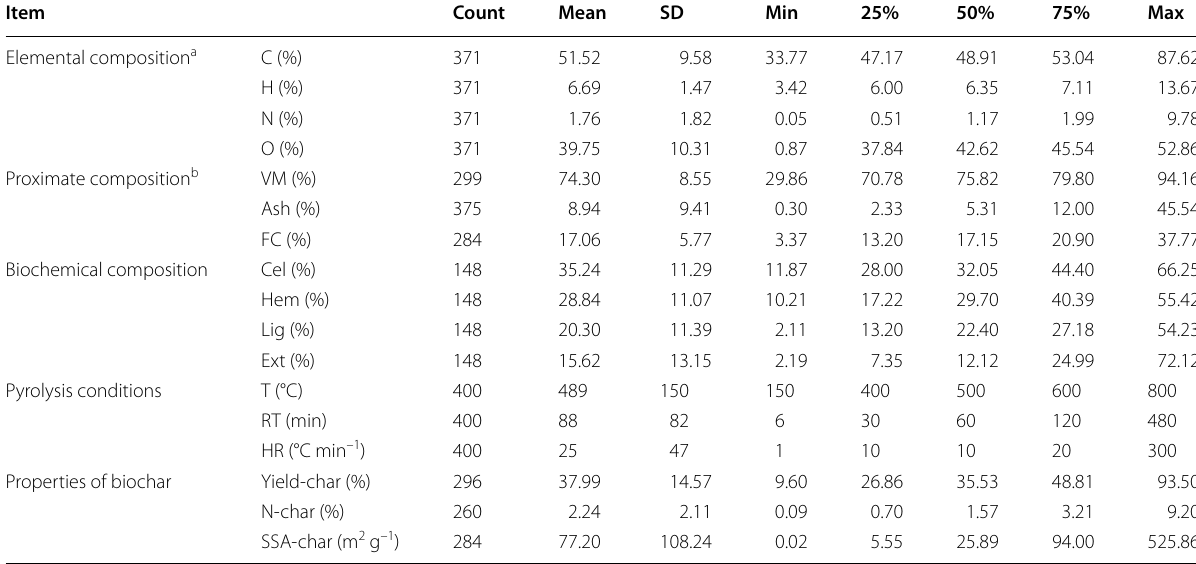
a On dry ash-free basis b On dry